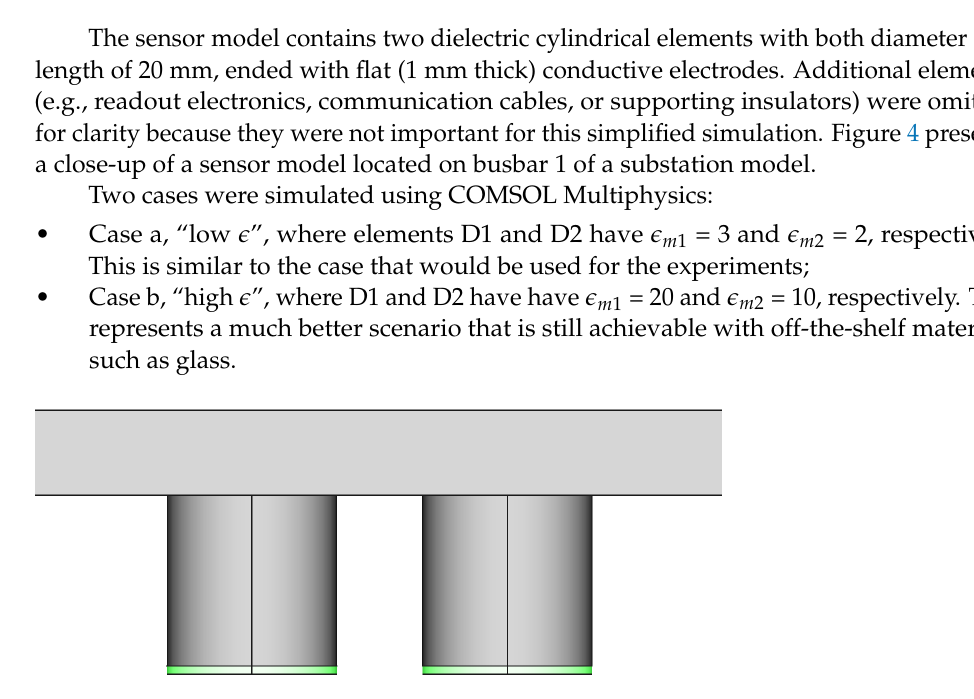
Figure 3. The model used for FEM simulations, with an envelope represented as a wire-frame to show busbar and sensor models.